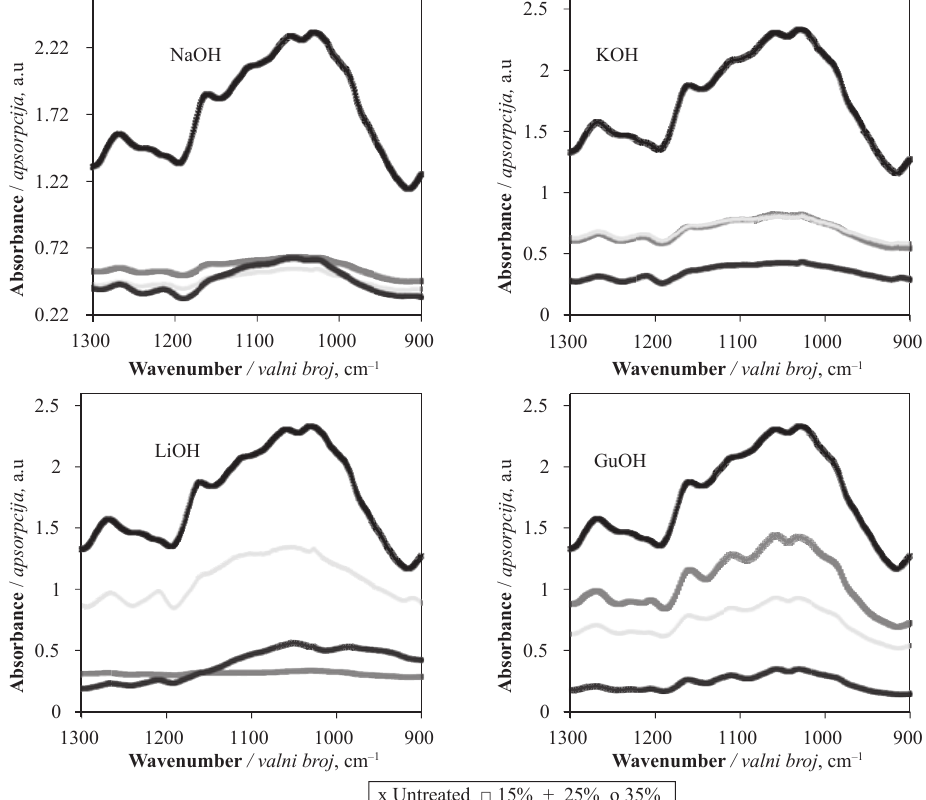
Figure 6 C-O stretch of the substituted benzyl ether Slika 6 . C-O dio etera koji je supstituiran